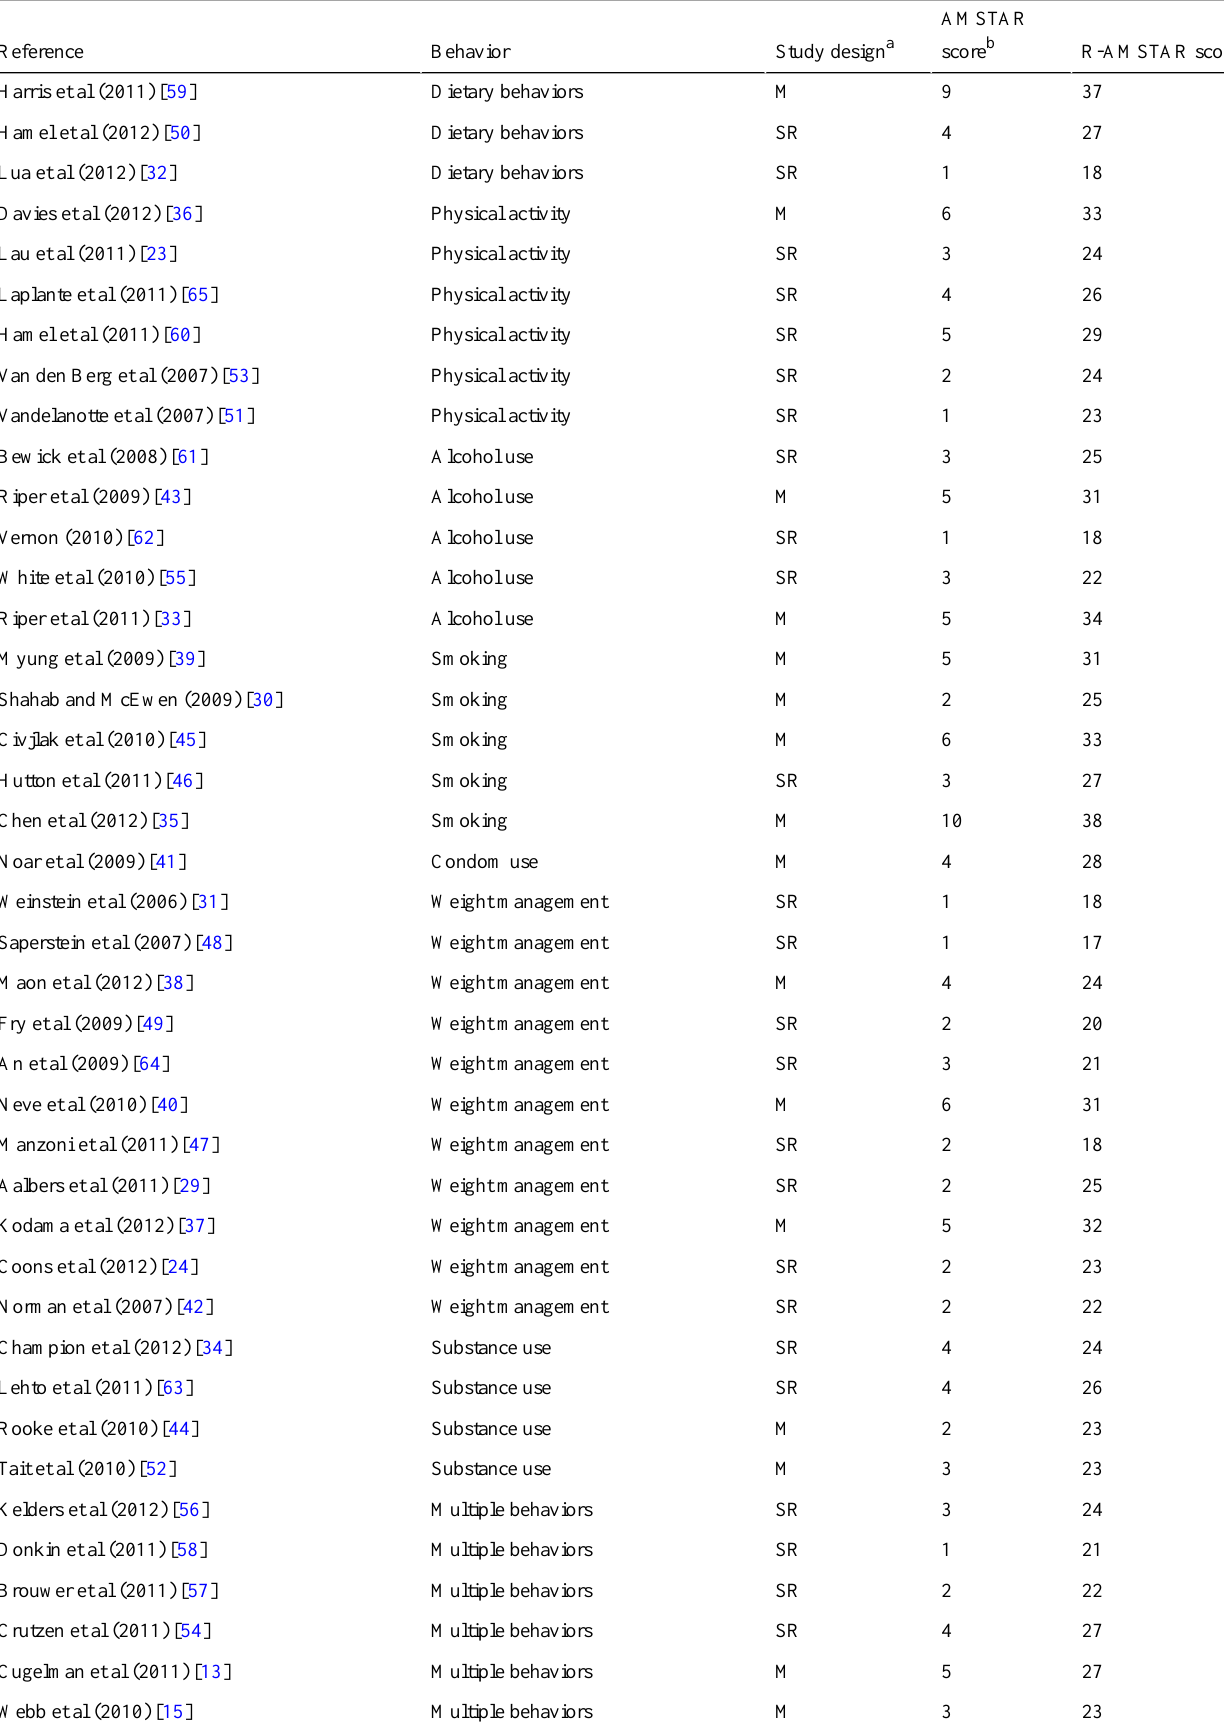
Table 1. Quality assessment of included